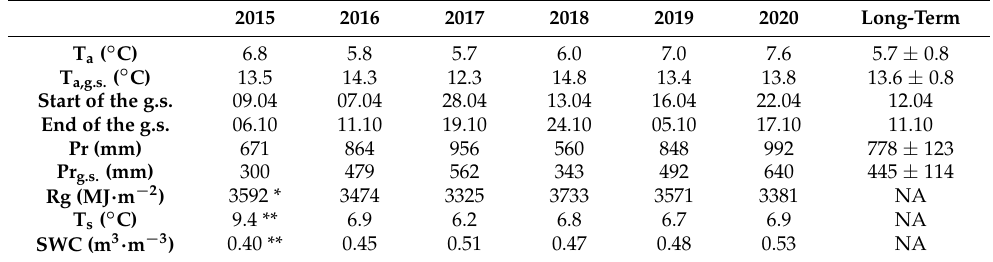
Table 1. Meteorological conditions in the period 2016–2020: mean annual air temperature (T a ); mean air temperature calculated for the long-term growing season (LTGS, 12 April–11 October) (T a,g.s. ) and the growing season (g.s.) start and the end dates at meteorological station “Toropets”; annual precipitation (Pr) and precipitation sums calculated for the LTGS period (Pr g.s. ) at meteorological station “Lesnoy Zapovednik” (MS) as well as the long-term (1991–2020) mean values of T a , T a,g.s , Pr, and Pr g.s with standard deviations ( ± SD); annual sums of global radiation (Rg); mean annual soil temperature (T s ) at 5 cm depth; and the mean annual soil water content (SWC) in the nemorose spruce forest.